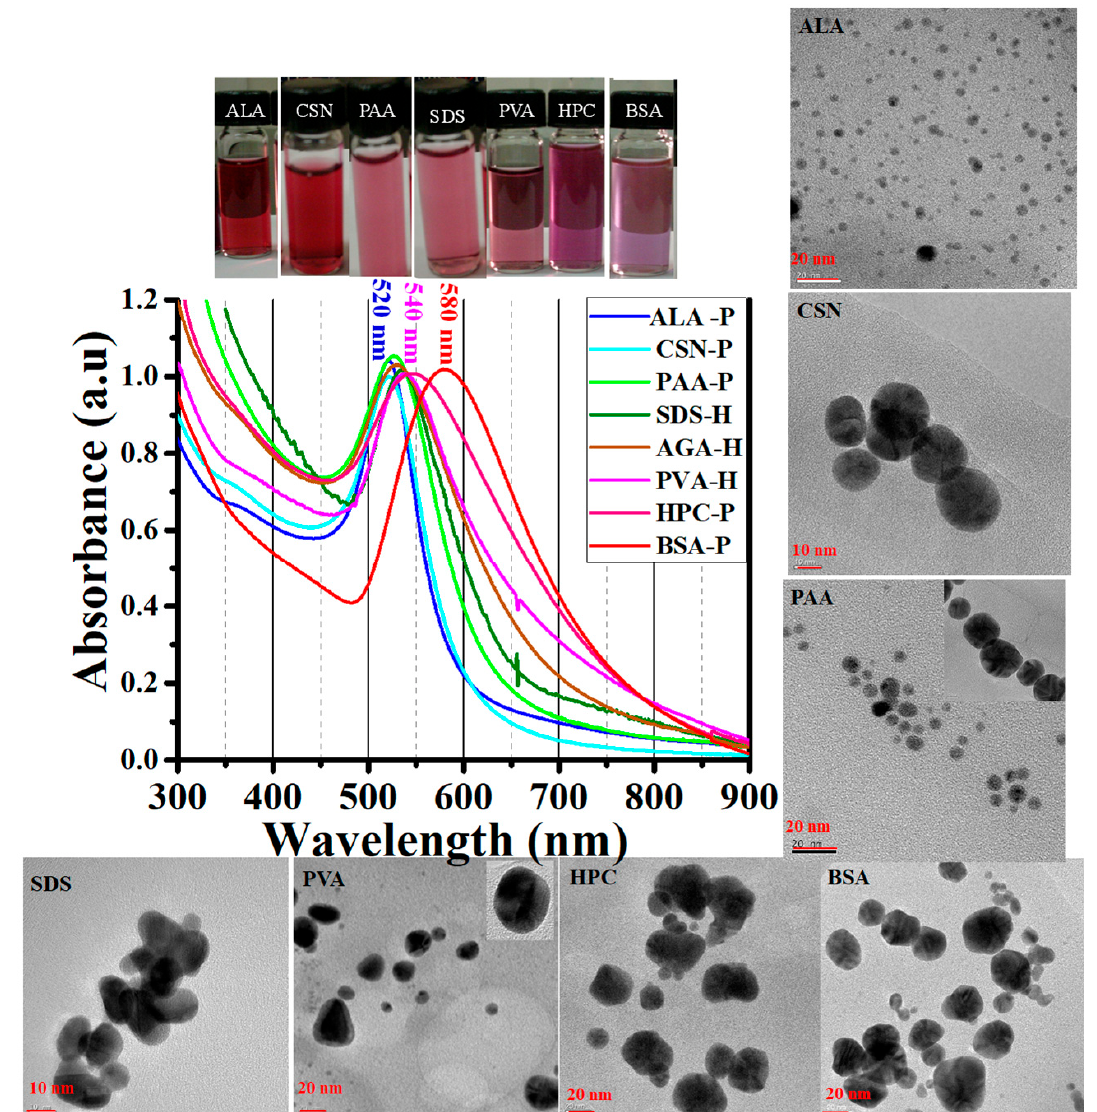
Figure 7. Characterization of spherical AuNPs stabilized in different polymers under photoirradiation (P) and heating (H) by daylight images, UV/VIS absorption spectra, and TEM images. ALA = alginic acid; CSN = chitosan; PAA = polyacrylic acid; SDS = sodium dodecyl sulfate; PVA = polyvinyl alcohol; HPC = hydroxypropyl cellulose; BSA = bovine serum albumin.